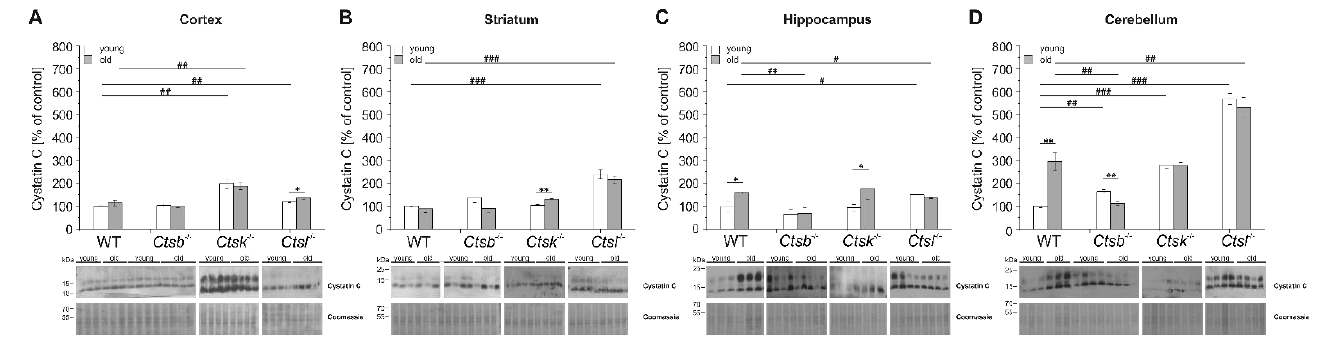
Figure 7. Status of cystatin C protein levels in the CNS of young and aged cathepsin-deficient mice compared to WT controls. ( A – D ) Densitometry analysis of immunoblots prepared from lysates of cerebral cortex, striatum, hippocampus, and cerebellum of young (white bars) and aged (gray bars) WT, Ctsb −/− , Ctsk −/− , and Ctsl −/− mice as indicated. Representative immunoblots are shown in the lower panels; lanes represent separate individuals. Coomassie-stained gels serve as a loading control. There were age-dependent decreases in cystatin C protein in cerebellum of Ctsb −/− mice and increases in striatum and hippocampus of aged Ctsk −/− mice, in cerebellum of aged Ctsl −/− mice, and in hippocampus of aged WT animals. Levels of significance between different ages are denoted as * or # for p < 0.05; ** or ## for p < 0.01; *** or ### for p < 0.001.